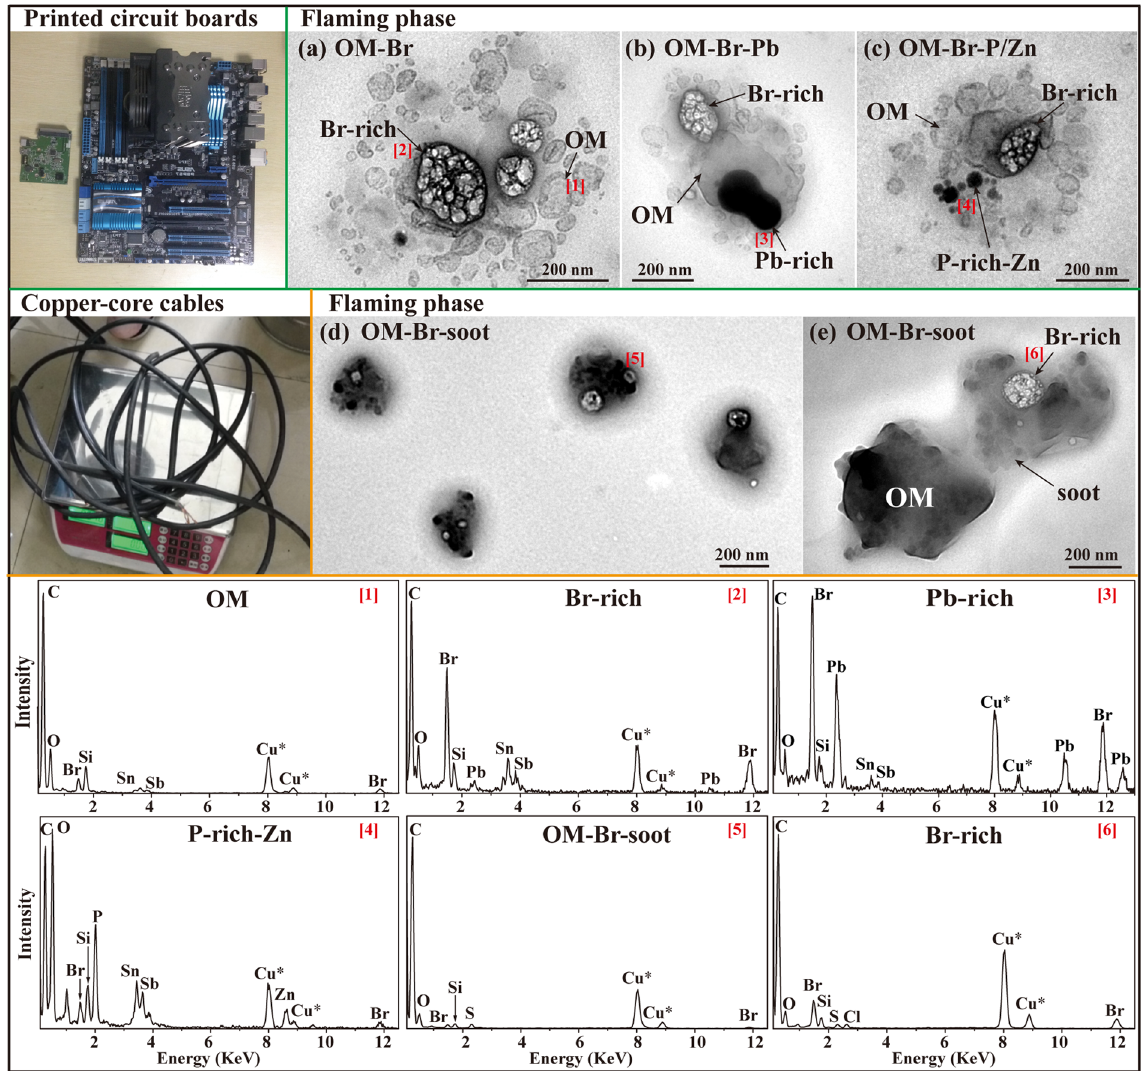
Figure 9. TEM images and EDS spectra of individual primary particles from the combustion of printed circuit boards and copper-core cables. ( a ) Br-rich particles internally mixed within bubble-like OM (Sn, Sb) from printed circuit boards in the flaming phase; ( b and c ) Bubble-like OM (Sn, Sb) internally mixed with Br-rich, Pb-rich, P-rich and Zn-rich from printed circuit boards in the flaming phase; ( d and e ) Low magnification and high resoluton TEM images of OM-Br-soot particles from copper-core cables in the flaming phase. The corresponding EDS spectra are indicated by the number in square brackets. The Cu * peaks in the EDS spectra are not analyzed because of the interference from the copper TEM